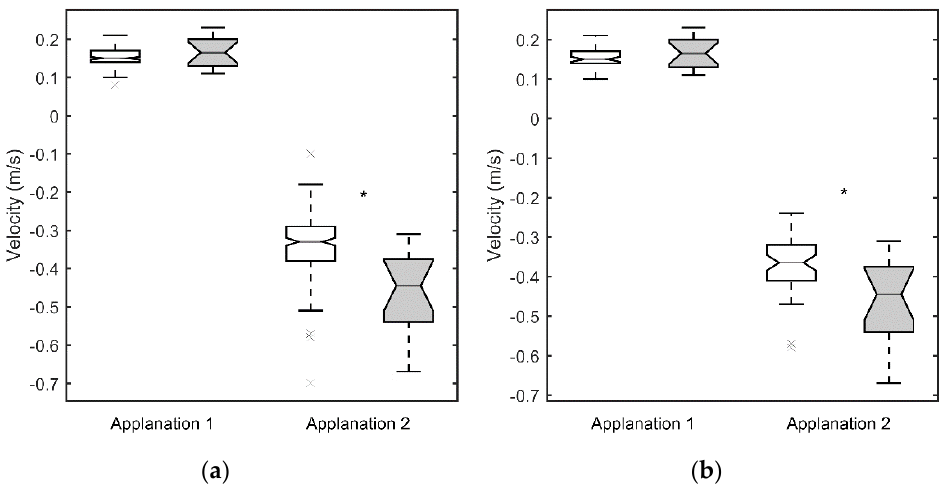
Figure 3. Velocity of deformation at first and second applanation for the SCKC (grey) and control groups (white). Symbols as in Figure 1. ( a ) whole control group, ( b ) IOP and CCT matched control group.